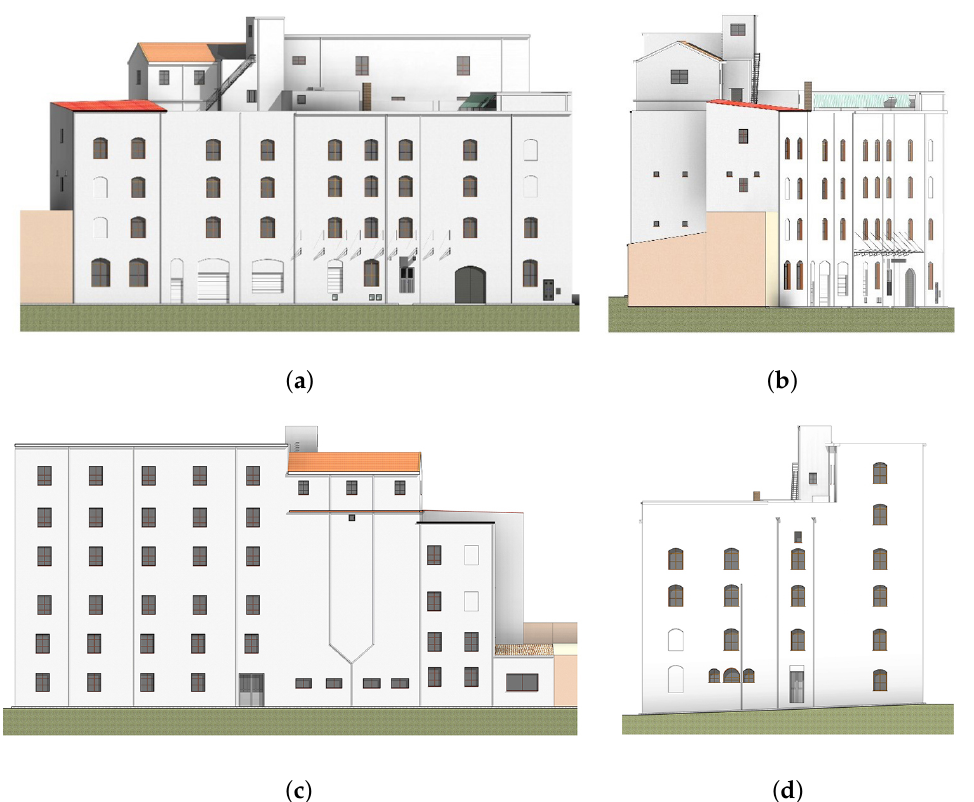
Figure 11. Digital drawings: main elevations. ( a ) North Elevation on the Maggiore Guida street; ( b ) East Elevation on the other property; ( c ) South Elevation on the Tarollo street; ( d ) West Elevation on the Pozzo del Grillo